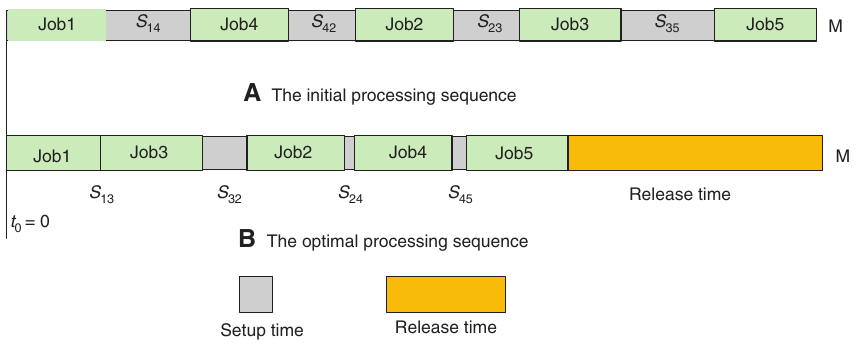
Figure 1: Schematic Diagram of SMS with Setup